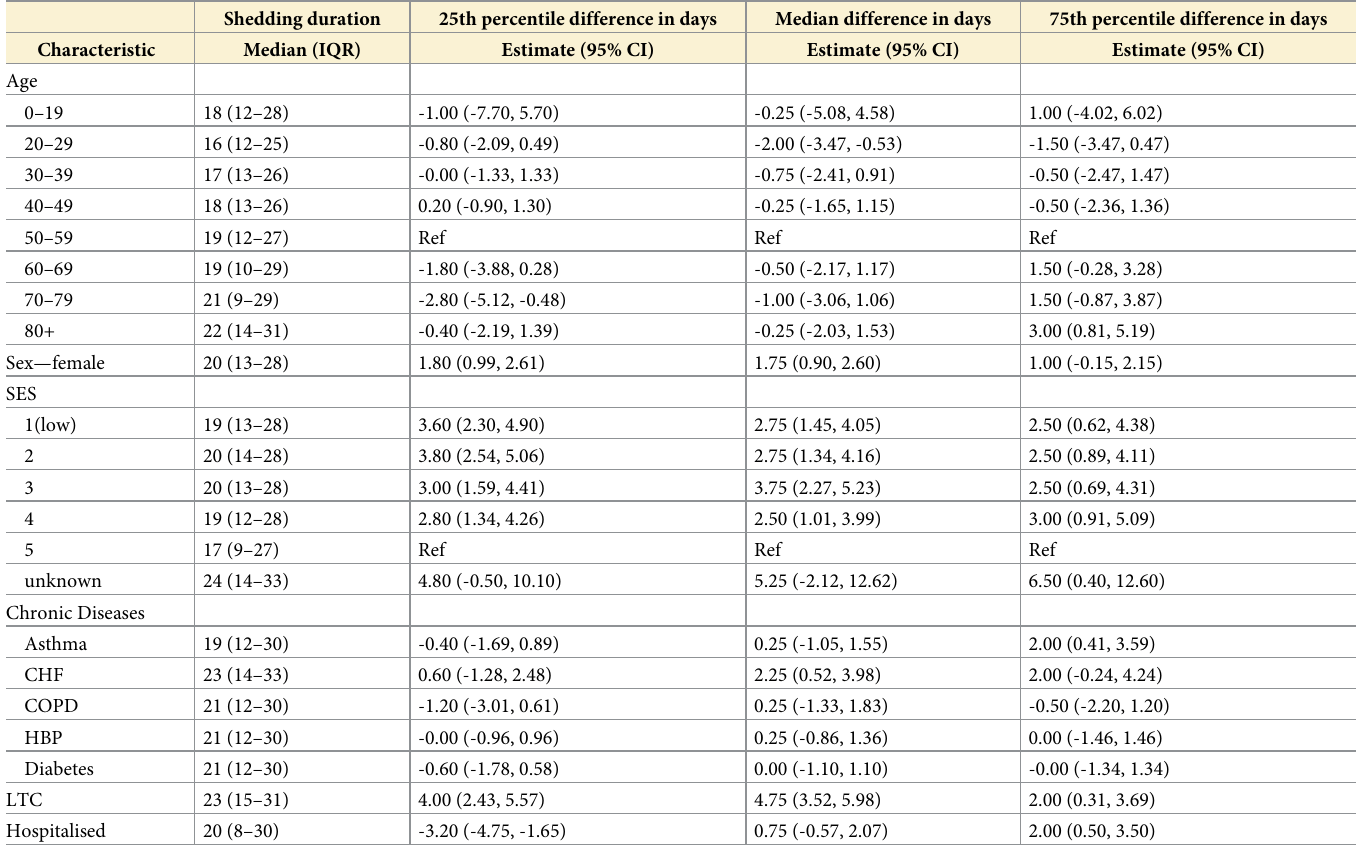
Table 3. Multivariable quantile regression, factors associated with shedding duration (N = 4889). Shedding